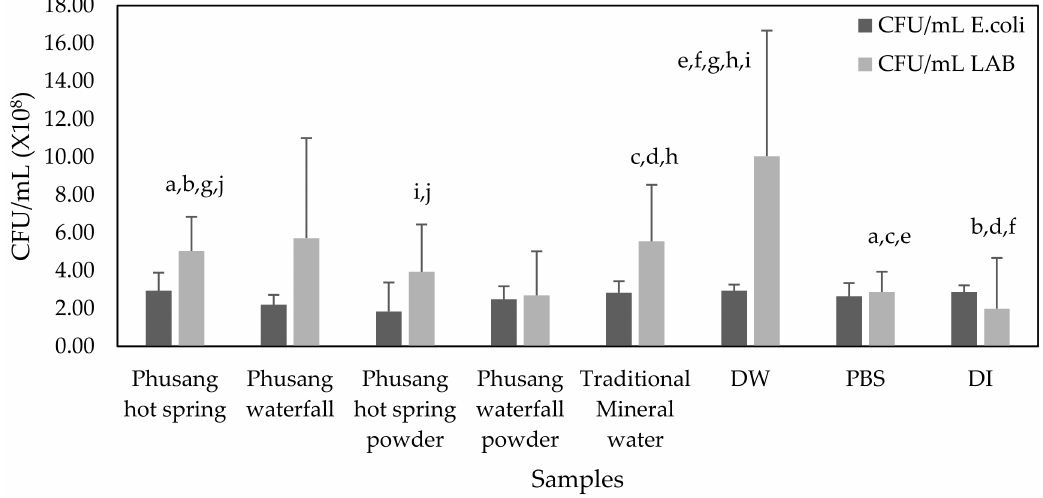
Figure 13. Differences in E. coli and LAB CFUs/mL between groups treated with different water samples. (a, b, c, d, e, f, g, h, i, and j = statistically significant